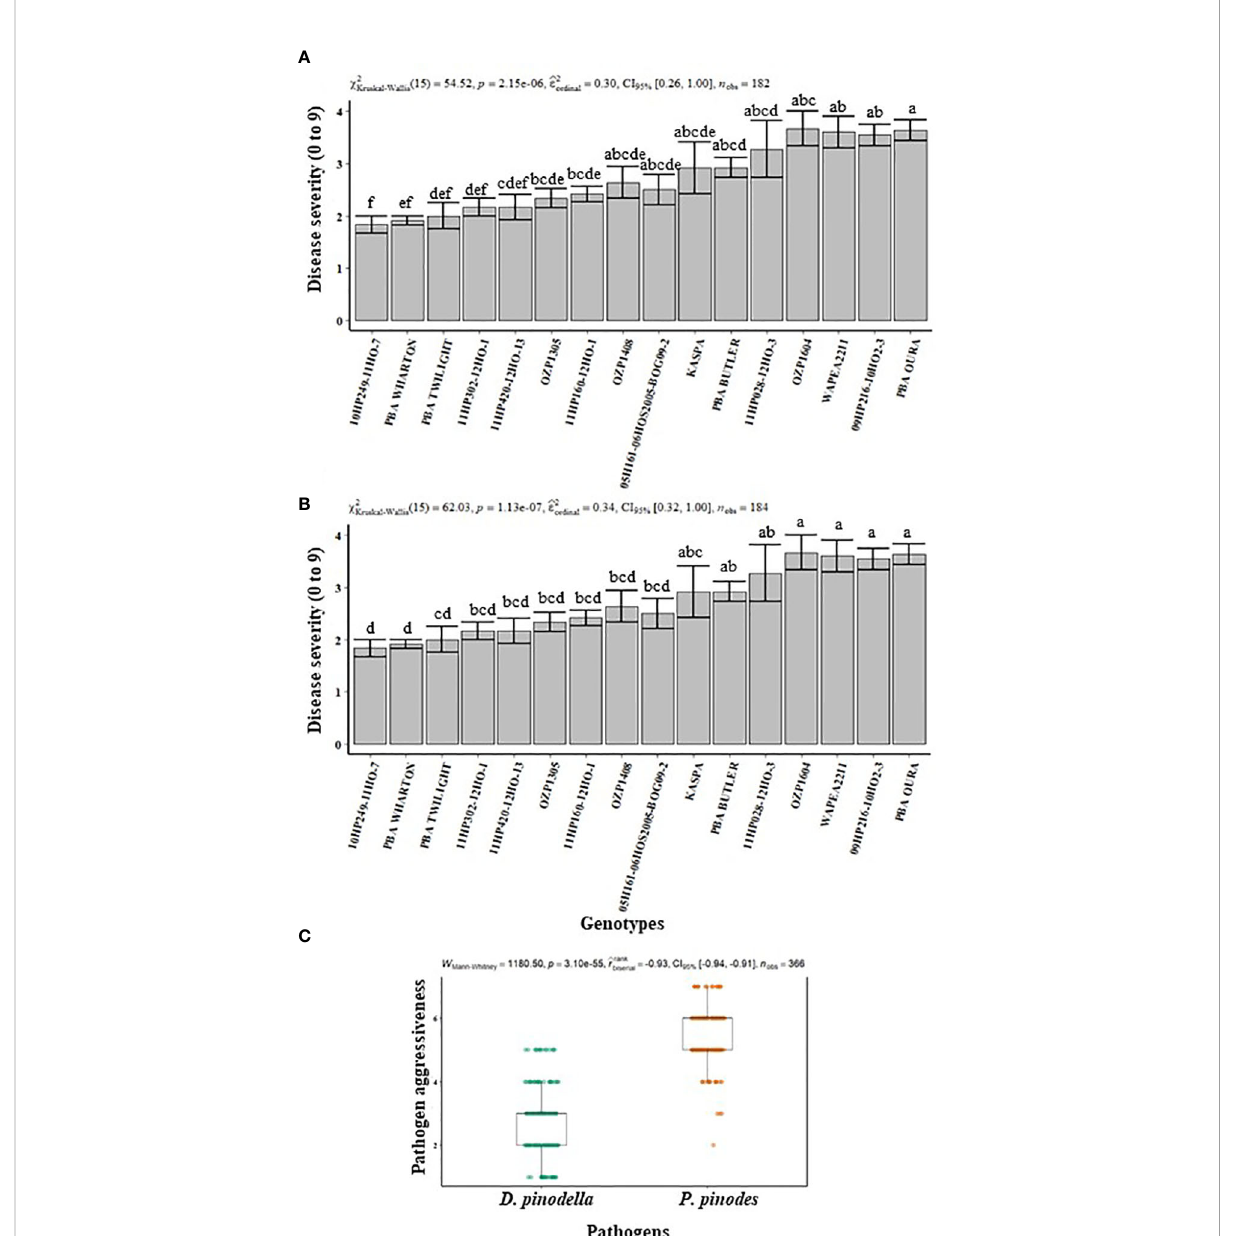
FIGURE 1 Disease severity (A, B) and pathogen aggressiveness (C) observed in fi eld pea plants inoculated with Peyronellaea pinodes and Didymella pinodella at controlled environment facility in Horsham. The data are presented as mean ± SEM. Different letters on each bar signi fi es statistical signi fi cance among genotypes at P < 0.05 level for P. pinodes and D .